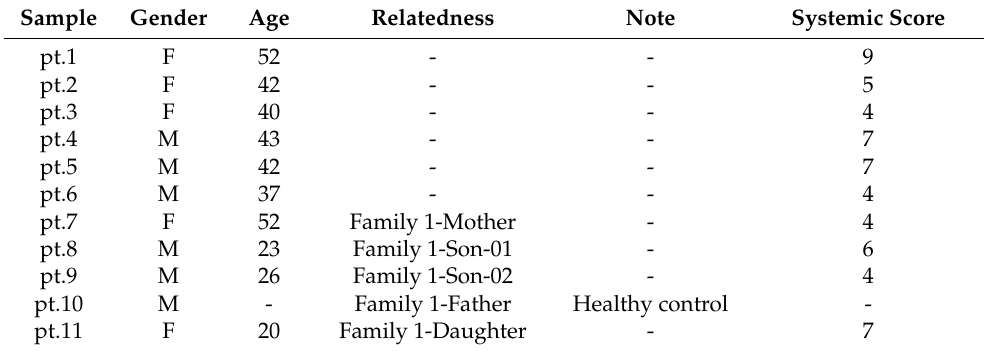
Table 1. Basal characteristic of MFS